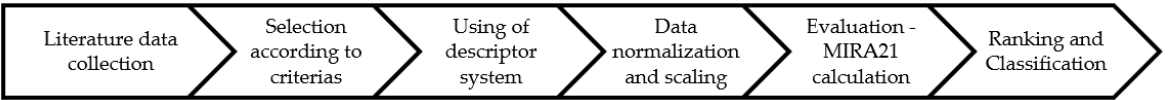
Figure 13. Process steps of MIRA21 model .